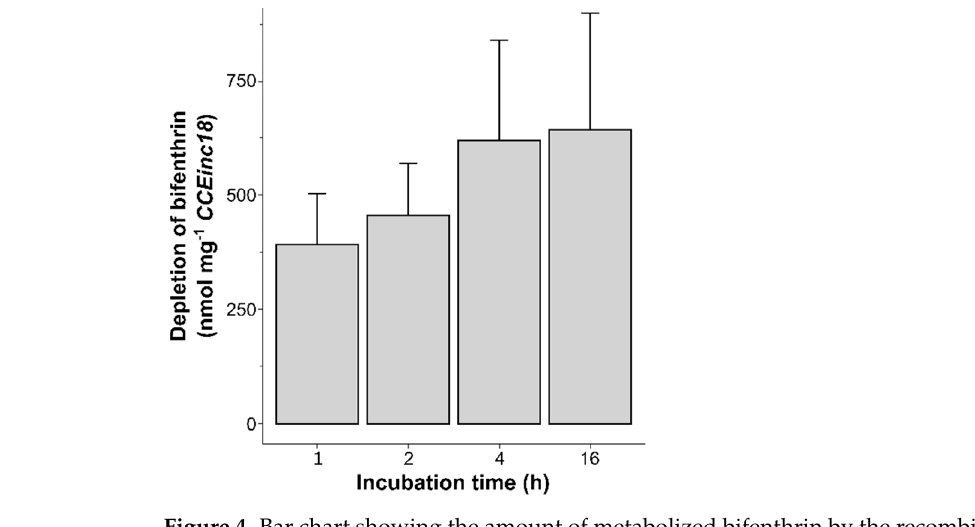
Table 4. Glycosylation characteristics of teturUGT29 and teturUGT10 in combination with bifenthrin, TFP-acid and bifenthrin-alcohol.